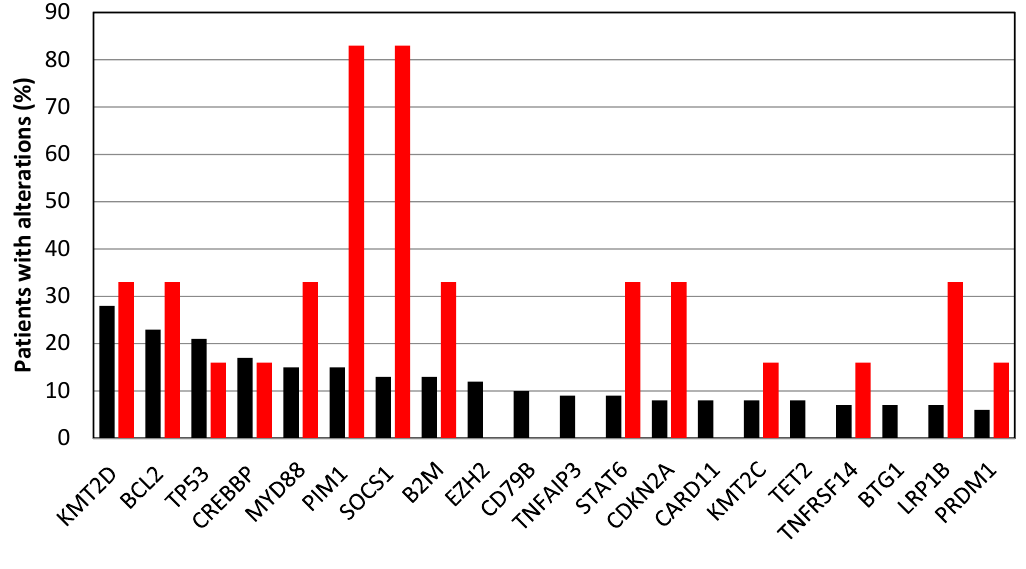
Figure 1. Frequency of mutations in the top-20 most commonly mutated genes in diffuse large B-cell lymphoma according to the Cosmic database version 86, and as observed in the 14 tumor samples analyzed in this study. Fourteen of the 20 genes were mutated in at least one of the 14 samples. SOC1 and PIM1 mutations were observed in 5 of 6 patients.